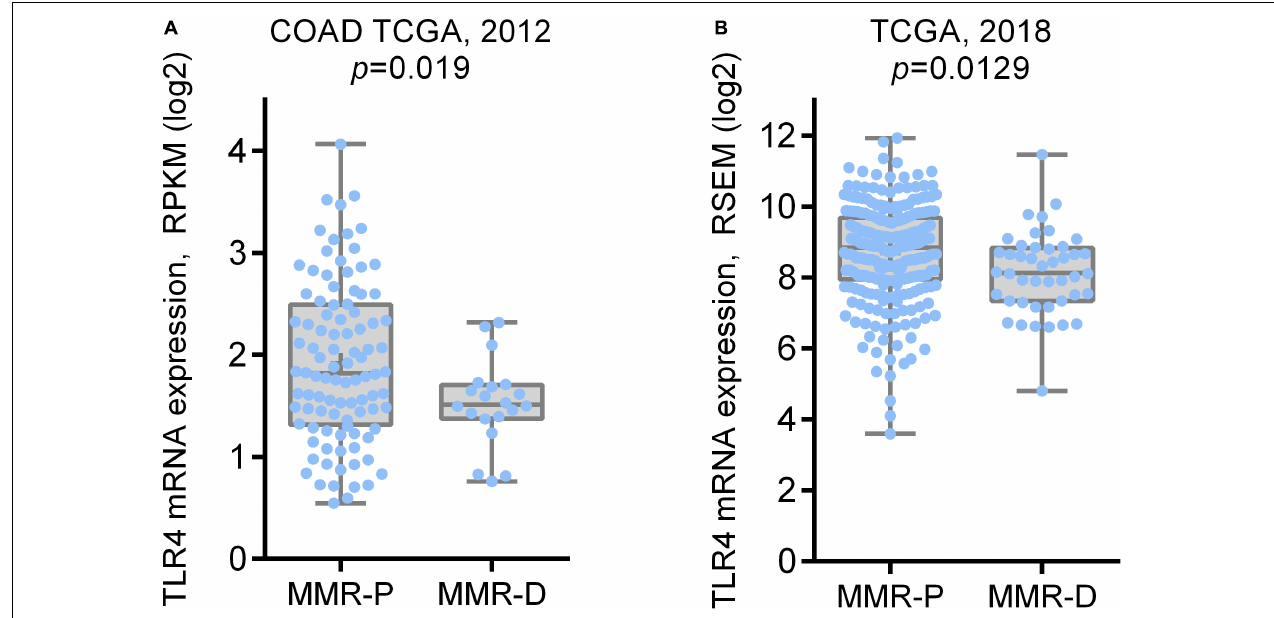
FIGURE 1 | TLR4 mRNA expression in colon adenocarcinoma TCGA dataset according to MMR status. (A) TLR4 mRNA expression in MMR proficient (MMR-P: MSS subtype) and MMR deficient (MMR-D: MSI-H and MSI-L subtype) samples in COAD TCGA dataset; (B) TLR4 mRNA expression in MMR proficient (CIN, GS, and POLE subtypes) and MMR deficient (MSI subtype) samples in TCGA PanCancer Atlas